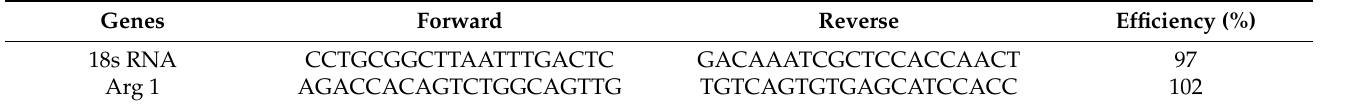
Table 1. Sequence of primers from Invitrogen.